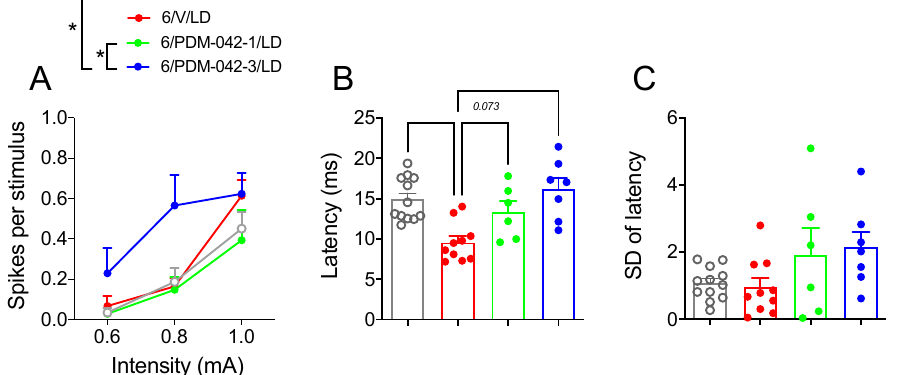
Figure 8. The PDE10A inhibitor PDM ‐ 042 alters corticostriatal signaling in LID . ( A ) PDM ‐ 042 3 mg/kg but not 1 mg/kg facilitated cortically evoked spike activity in unidentified striatal MSNs recorded in the ipsilateral striatum (* p < 0.05 vs. S/V/V and 6/PDM ‐ 042 ‐ 1/LD groups, two ‐ way RM ‐ ANOVA and Holm ‐ Sidak post ‐ hoc test). ( B ) PDM ‐ 042 (1 and 3 mg/kg) prevented L ‐ DOPA ‐ induced reduction of spike latency ( p > 0.05 vs. S/V/V group, one ‐ way RM ‐ ANOVA and Holm ‐ Sidak post ‐ hoc test). ( C ) PDM ‐ 042 (1 and 3 mg/kg) had no effect on the standard deviation of spike latency ( p > 0.05, one ‐ way RM ‐ ANOVA and Holm ‐ Sidak post ‐ hoc test). Data are presented as the mean ± SEM. Results are derived from n = 10/12 animals/cells in the S/V/V group, 6/10 animals/cells in the 6/V/LD group, n = 4/6 animals/cells in the 6/PDM ‐ 042 ‐ 1/LD group, and n = 5/7 animals/cells in the 6/PDM ‐ 042 ‐ 3/LD group.